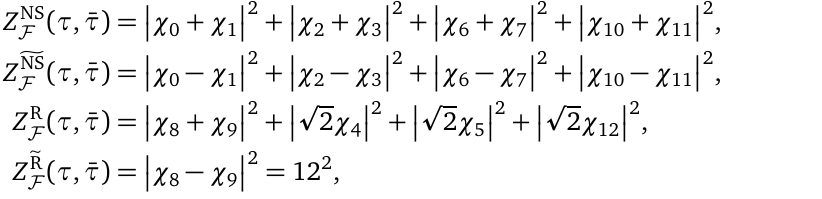
× (cid:90) B × (cid:90) C symmetry, each of which can be generated by 2 2 2